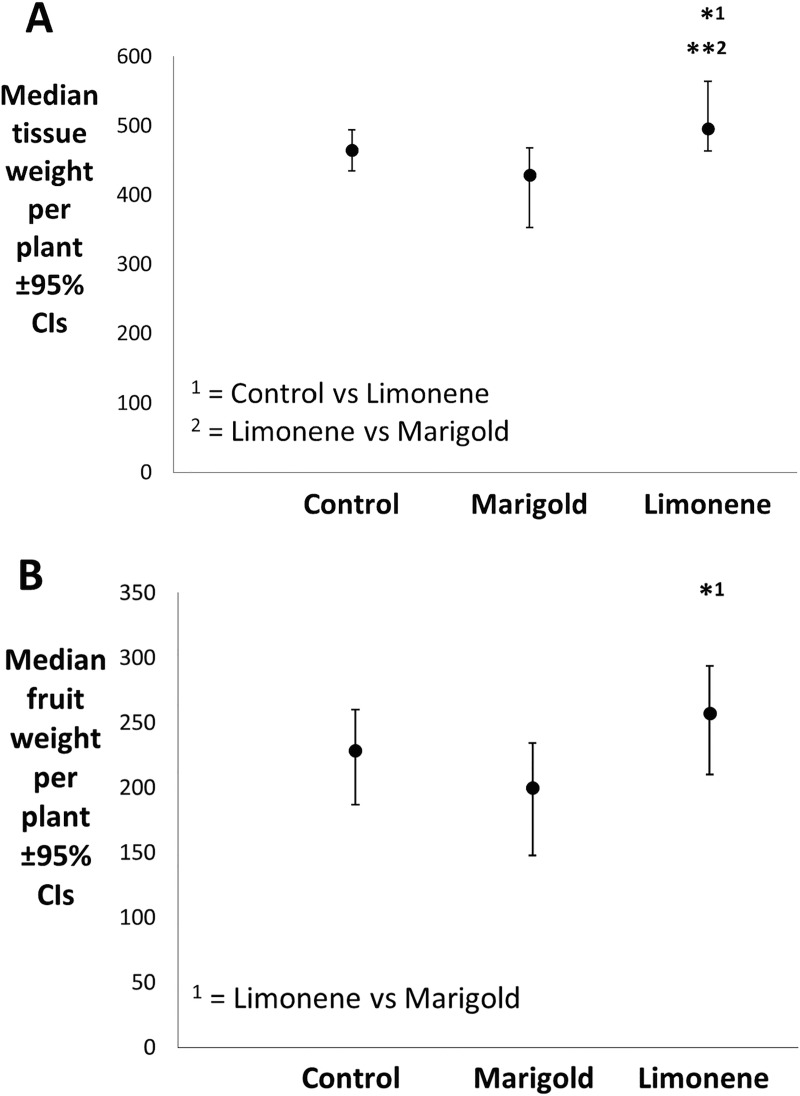
Plant development characteristics at the end of the 2017 assay into the efficacy of marigolds and limonene as an emergency treatment for the control of established whitefly populations (n = 8).Fig 4A displays the median aboveground tissue weight of each focal tomato plant, excluding tomatoes, at the end of the 29 day experiment (n = 8). Tomato plants from the marigold treatment were near-significantly lighter than tomato plants from the control (t = -1.86, df = 14, p = 0.085) and significantly lighter than tomato plants from the limonene treatment (t = -3.3, df = 14, p = 0.005) according to t-tests. Tomato plants from the limonene treatment were significantly heavier than those from the control according to a t-test (t = 2.15, df = 14, p = 0.05). Fig 4B displays the median weight of all tomatoes from each focal tomato plant at the end of the 29 day experiment (n = 8). The total tomato weight from plants in the marigold treatment was near-significantly lower than plants in the control (t = -1.76, df = 14, p = 0.100) and significantly lower than the total tomato weight of plants from the limonene treatment (t = -2.8, df = 14, p = 0.014). There was no significant difference in tomato weight between the control and limonene treatment.